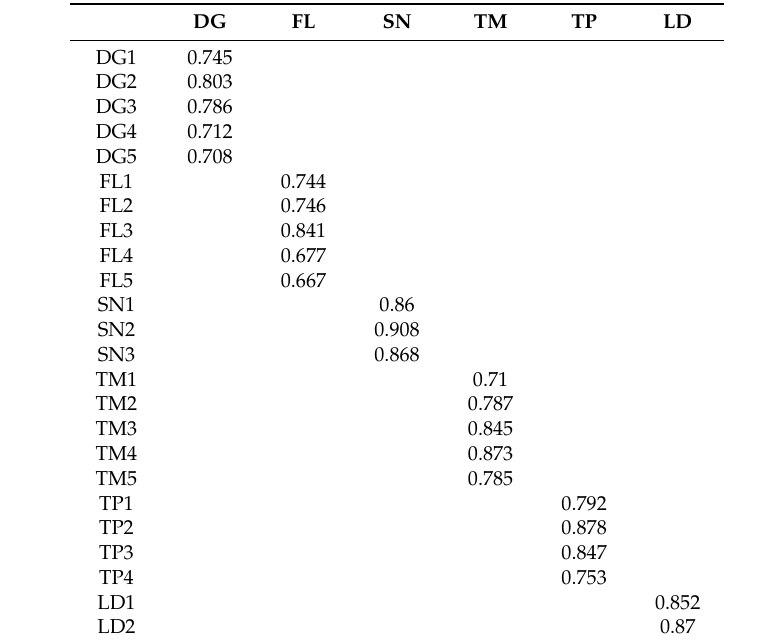
Table 3. Loadings and